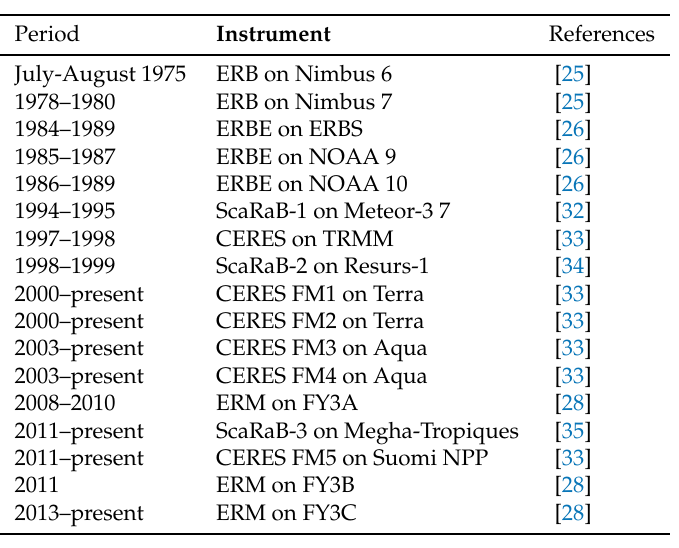
Table 4. Scanning Broadband Earth Radiation Budget space instruments on Low Earth Orbit satellites. CERES: Clouds and the Earth’s Radiant Energy System; ScaRaB: Scanning Radiometer for Radiation Balance; TRMM: Tropical Rainfall Measuring Mission; NPP: National Polar-orbiting Operational Environmental Satellite System Preparatory Project.